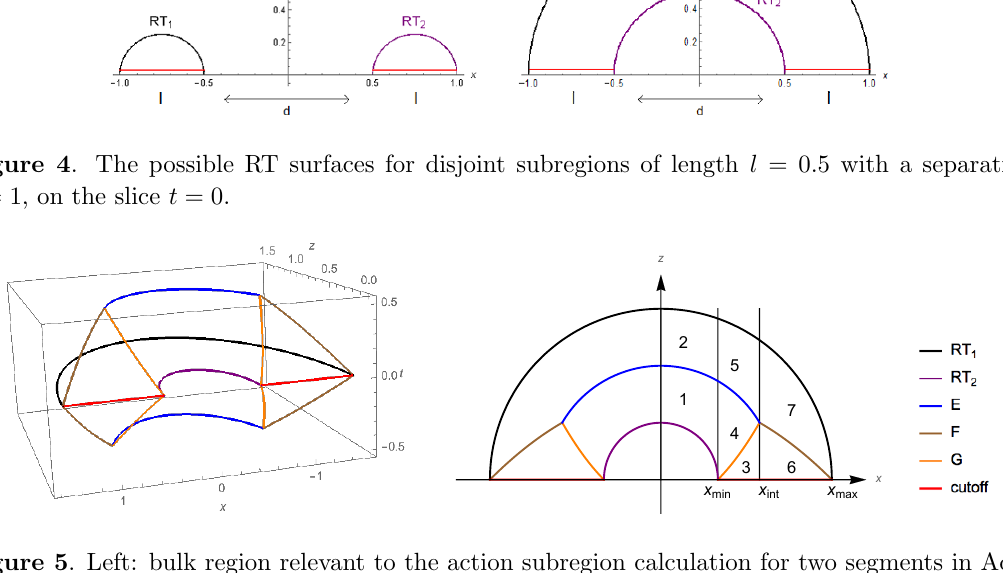
Figure 5 . Left: bulk region relevant to the action subregion calculation for two segments in AdS. Right: projection in the ( x; z ) plane. The regions in which the bulk integral is splitted are numbered. x > 0 and introduce opportune symmetry factors. A schematic representation is shown in (cid:12)gure